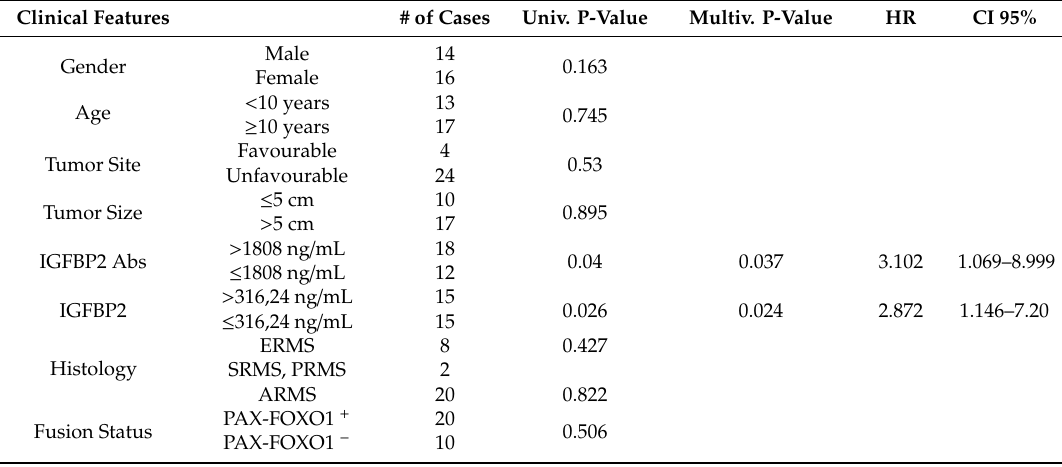
Table 3. Uni- and multivariate Cox regression analysis for overall survival in 30 metastatic RMS